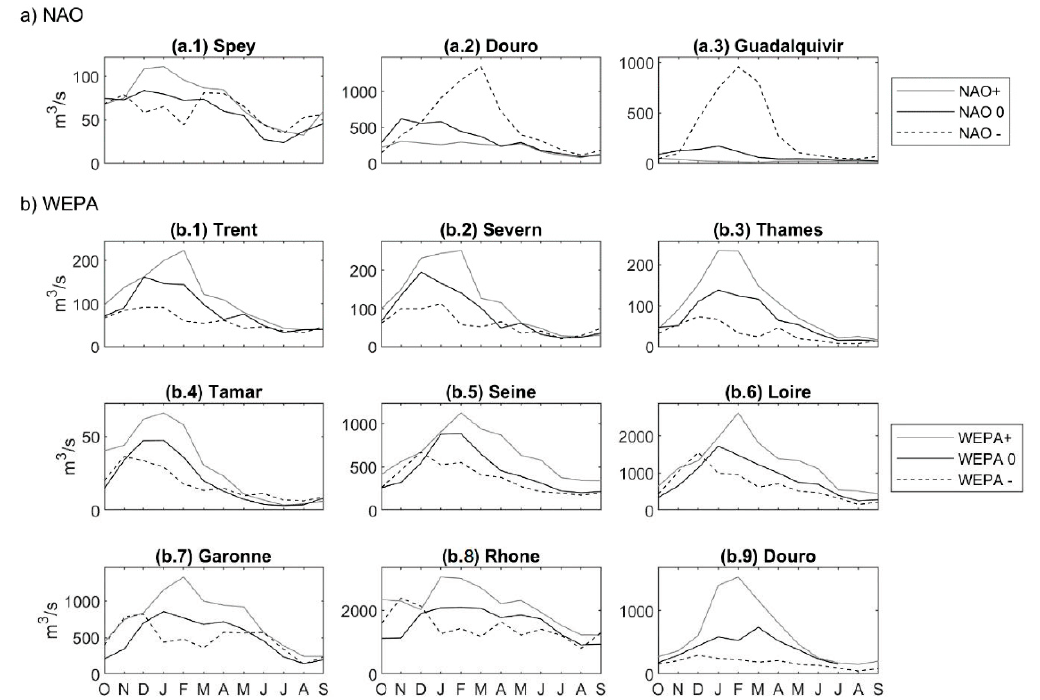
Figure 3. Mean monthly river discharge for the years characterized by strong positive (+), neutral (0), or negative ( − ) phases of the ( a ) NAO and ( b ) WEPA indices, calculated by averaging the discharges in the five years with the largest, closest-to-zero, and smallest indices, respectively: (NAO+) 1989, 1995, 200, 2012, and 2015; (NAO0) 1961, 1967, 1973, 1976, 1982; (NAO − ) 1963, 1964, 1969, 1977, 2010; (WEPA+) 1977, 1994, 2001, 2014, 2016; (WEPA0) 1958, 1959, 1967, 2010, 1984; (WEPA − ) 1953, 1976, 1992, 1993, 2005.